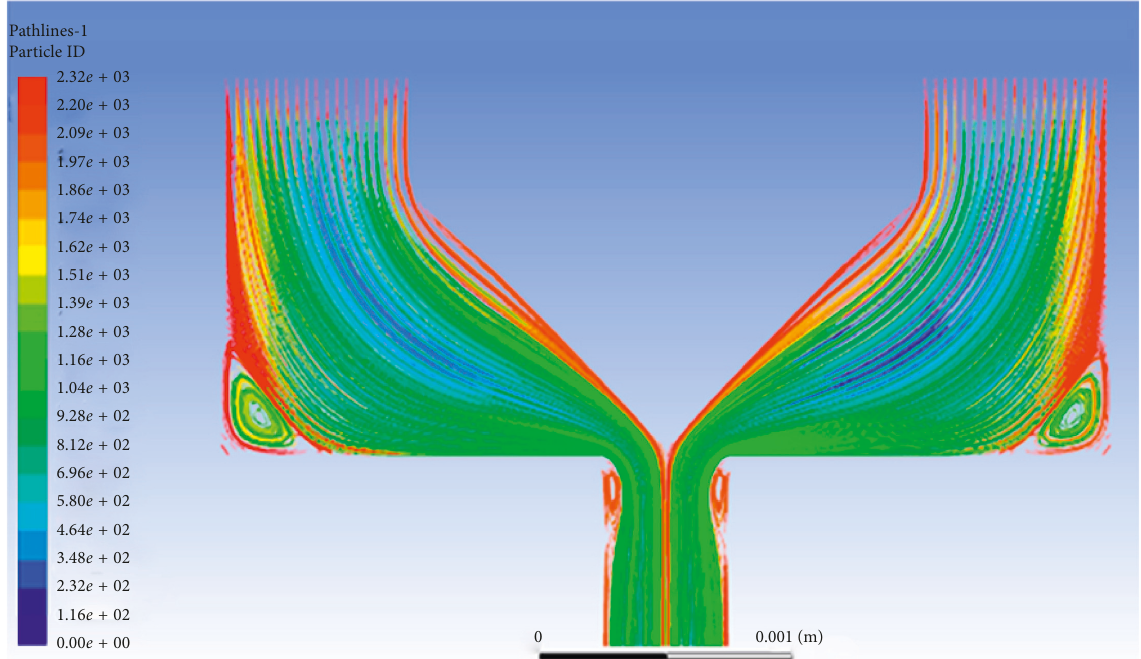
Figure 26: Flow streamline when the poppet valve core angle is 90 °